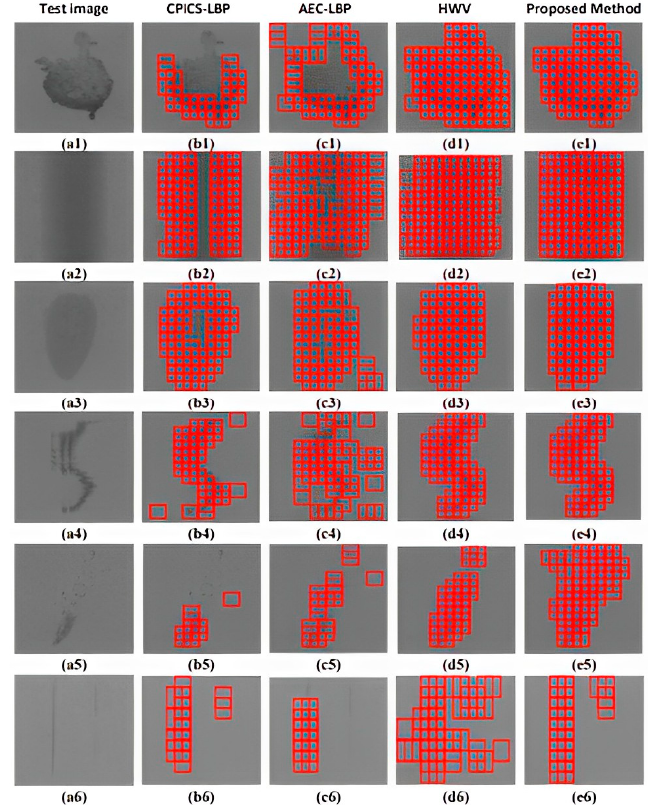
Figure 5. Presenting the results of experiments on six defect samples using four methods. The defect types are listed in the first column and include drops tar, shadow, floating, crush, pitted surface and scratch. The results from traditional manual feature extraction methods (CPICS-LBP, AEC-LBP, HWV and the proposed method in [53]) are shown in columns 2–5. The experiment compares the proposed method with current state-of-the-art methods in detecting strip steel surface defects.